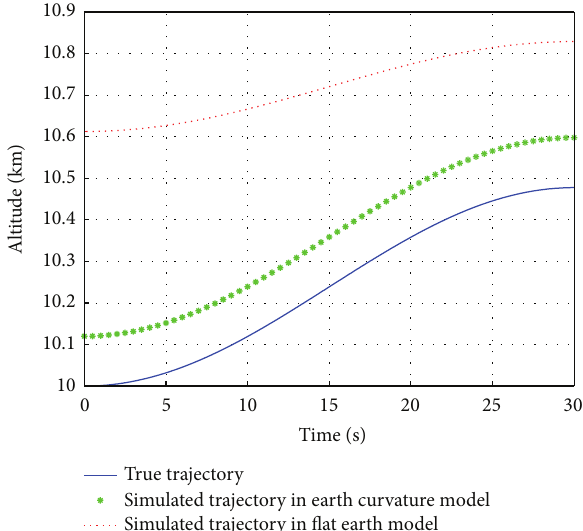
Figure 15: The comparison of the movement tracks calculated in two kinds of earth